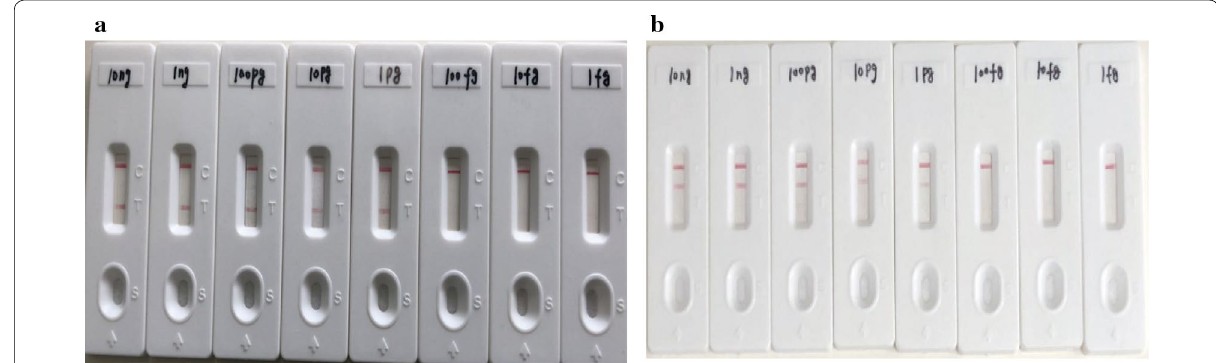
Fig. 6 The limit of detection of MABC–LAMP–LFD assay. Serial dilutions of M. abscessus - and M. massiliense -DNA template (10 ng, 1 ng, 100 pg, 10 pg, 1 pg, 100 fg, 10 fg, 1 fg) were used a The LoD of M. abscessus b The LoD of M.